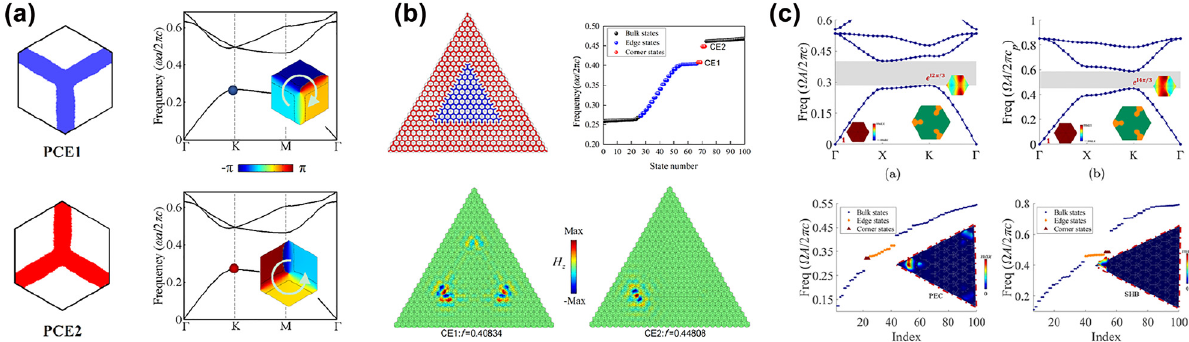
-symmetric lattices. (a) Optimized C symmetric photonic crystal and 3 3 -